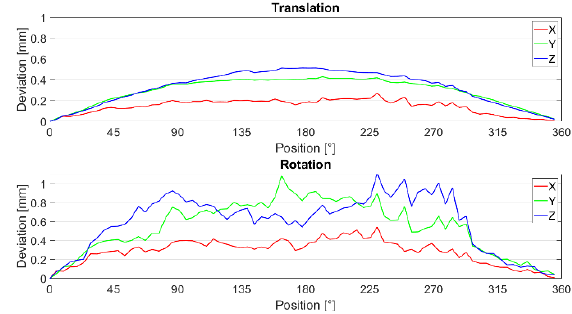
Figure 8 . Accuracy of the self-motion. The rotations are shown as metric